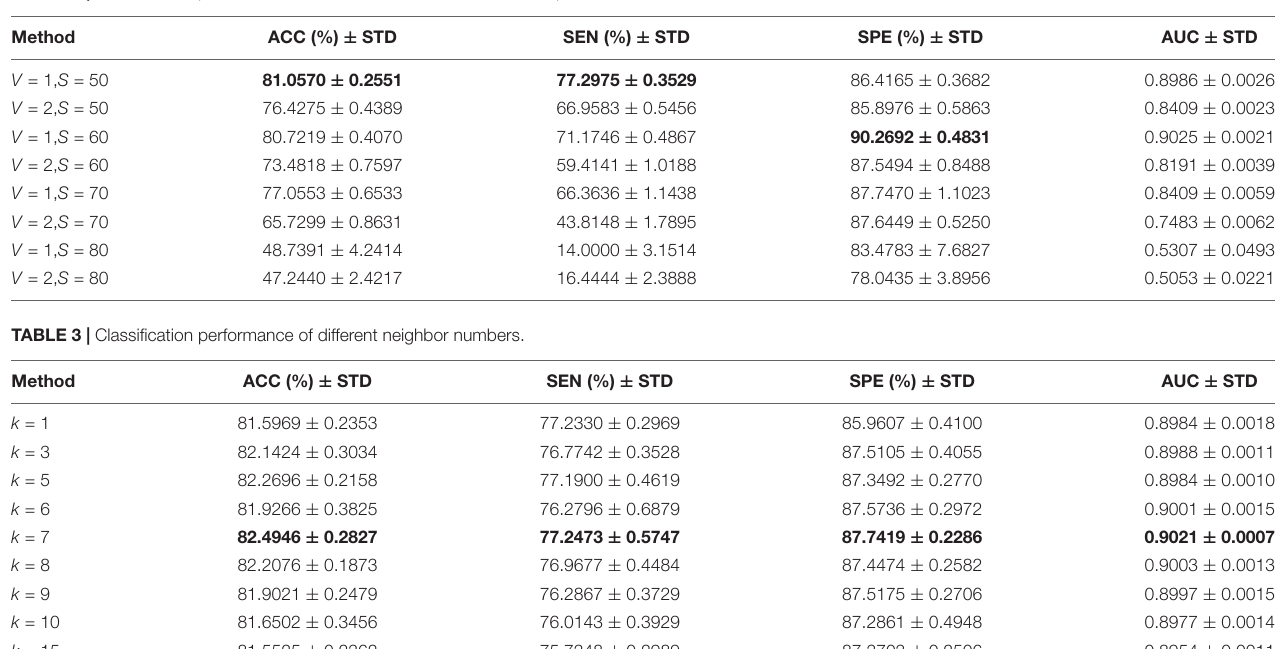
TABLE 2 | Classification performance of different window widths and step sizes.